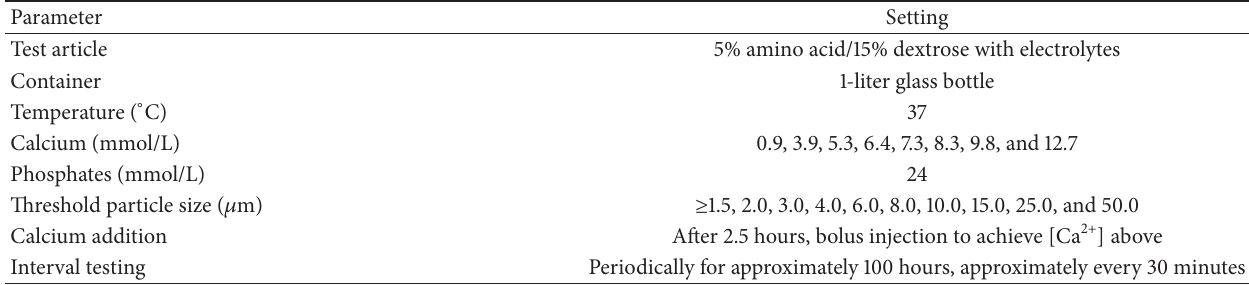
Table 2: Calcium phosphate solubility in an admixture—conditions for effect of [ Ca 2+ ] .